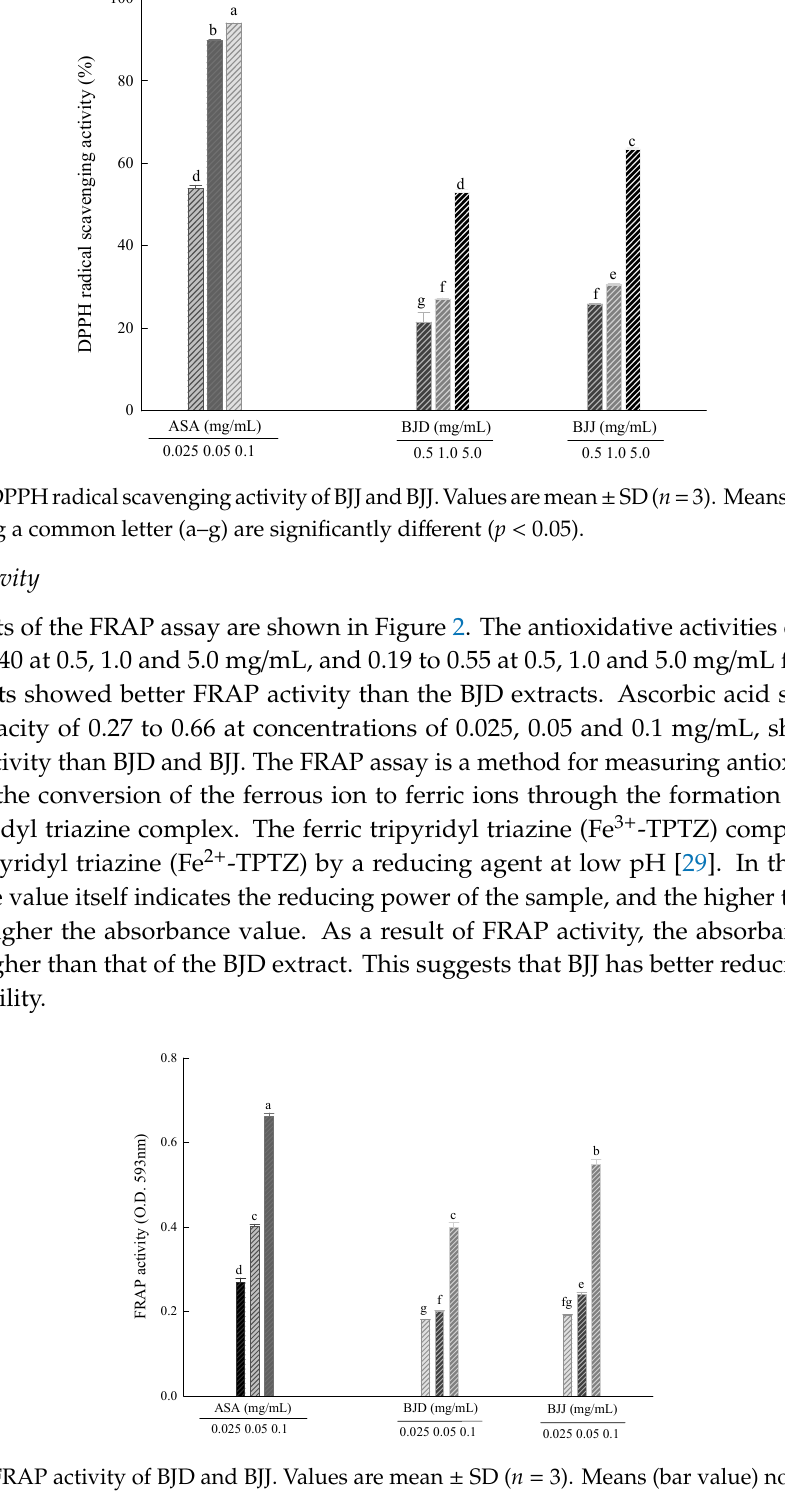
Figure 2. FRAP activity of BJD and BJJ. Values are mean ± SD ( n = 3). Means (bar value) not sharing a common letter (a–g) are significantly different ( p < 0.05).